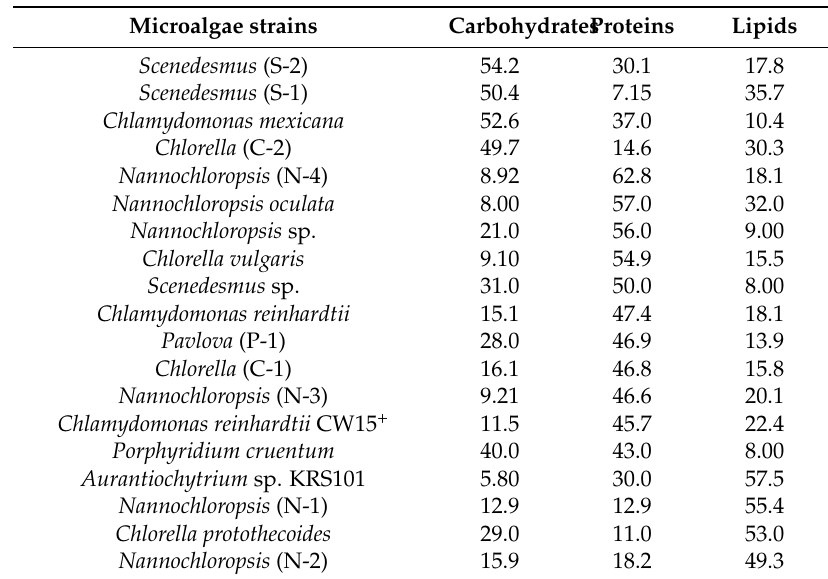
Table 1. Biochemical composition (wt. %, dry-basis) of various microalgae strains, adapted